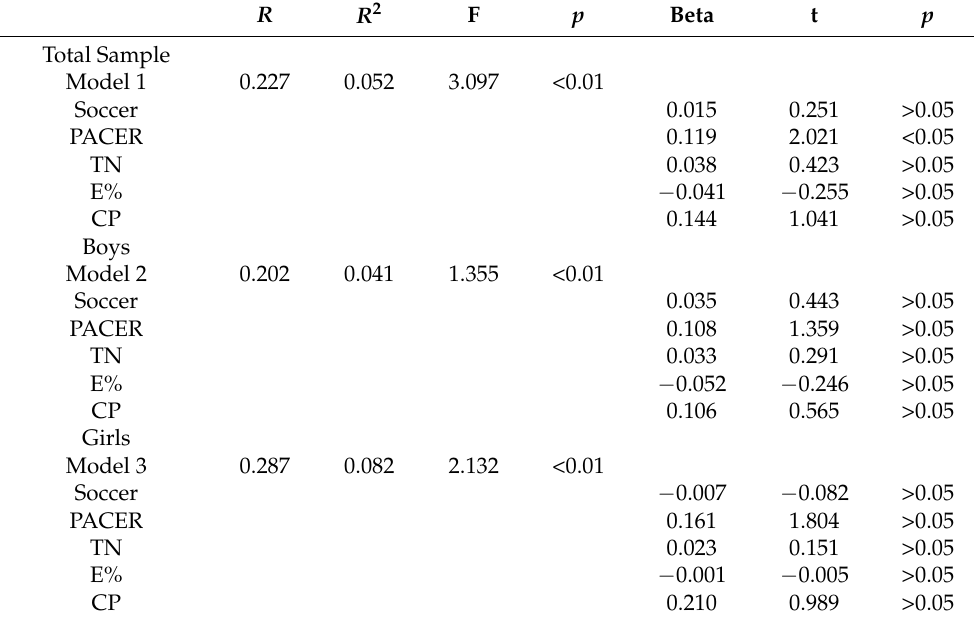
Table 3. Results of the linear regression model using manipulative skill competency, cardiorespiratory fitness, and cognitive function to predict the